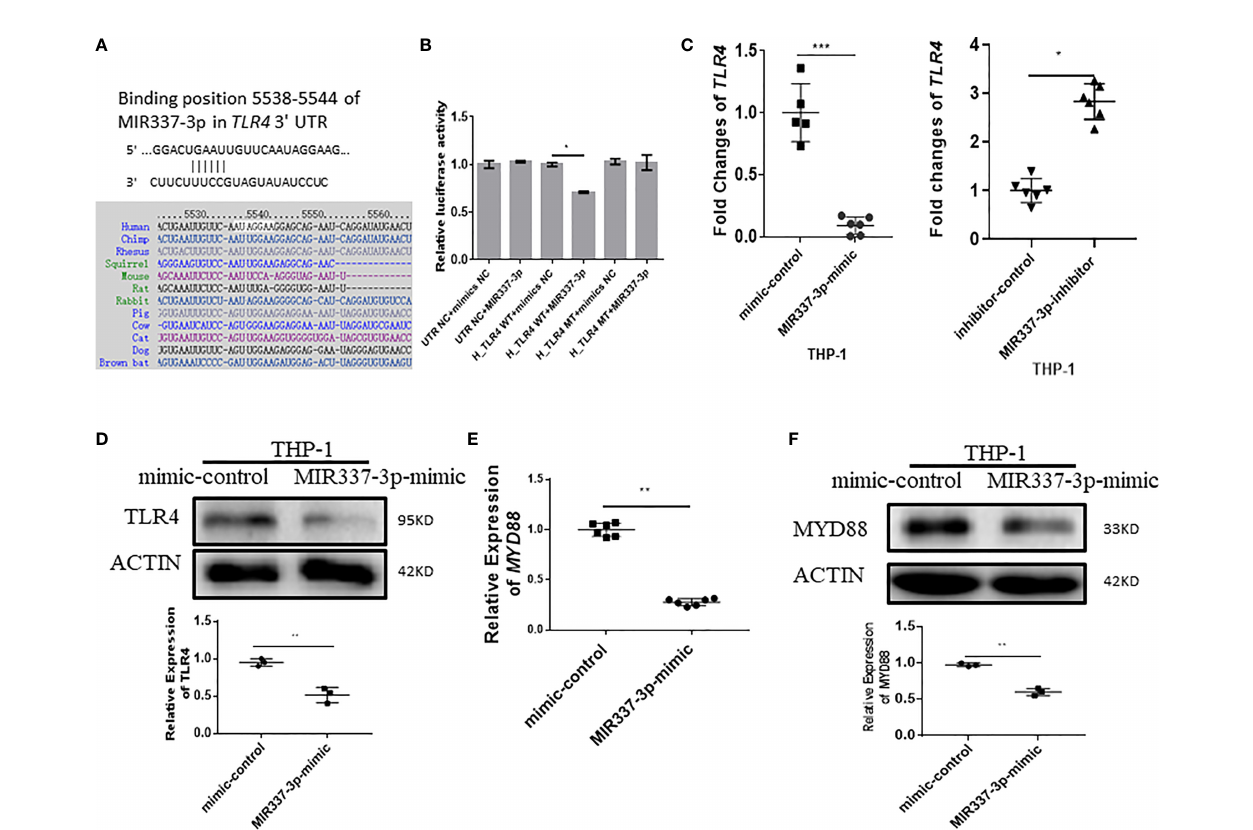
FIGURE 5 | MIR337-3p targeted the TLR4 3 ′ -UTR and depressed TLR4/MYD88 signal. (A) shows that the binding sites of MIR337-3p in TLR4 3 ′ -UTR were predicted by TargetScan software. (B) shows data of luciferase reporter assays, which were performed to test the interaction of MIR337-3p and its target TLR4 3 ′ - UTR using constructs containing the predicted targeting sequence (TLR4 WT) and mutant sequence (TLR4 MT) cloned into the 3 ′ -UTR of the reporter gene. (C) shows that transfection of MIR337-3p mimics inhibits the expression of TLR4 in THP-1 cells, and miR-337-3p inhibitors increased TLR4 expression compared to the controls at 24 h after transfection. (D) shows the representative result of Western blot (WB) indicating that MIR337-3p mimics inhibit TLR4 protein expression in THP-1 cells. (E) shows that MIR337-3p mimics inhibit expressions of MYD88 in THP-1 cells. (F) shows the representative WB result indicating that MIR337-3p mimics inhibit MYD88 protein expression in THP-1 cells. *P < 0.05, **P < 0.01, and ***P <